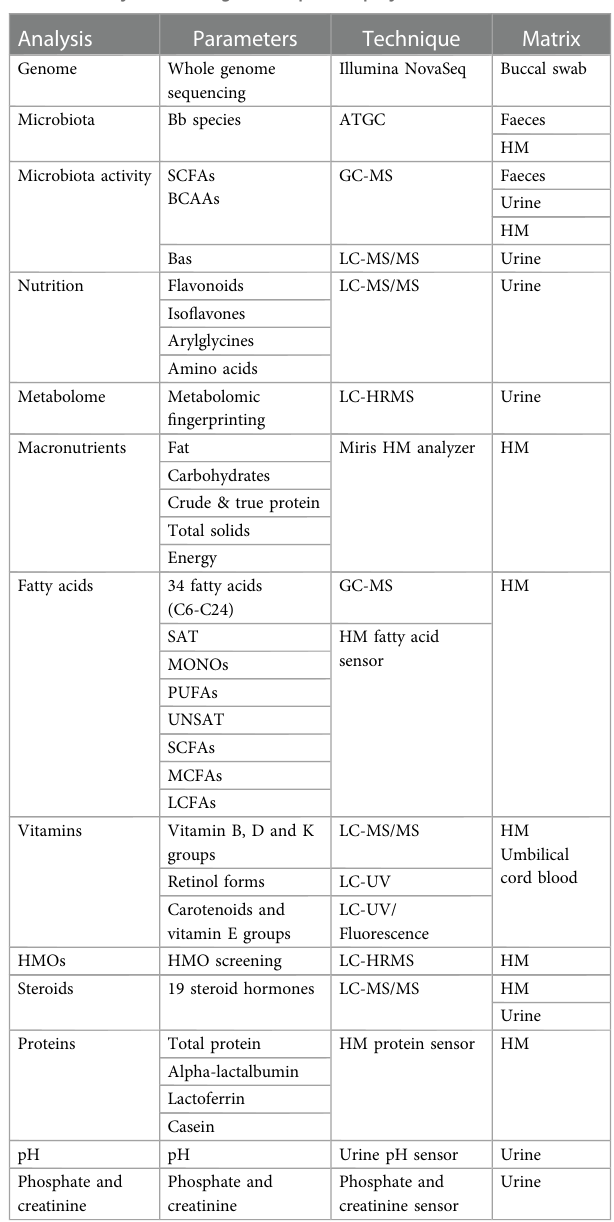
TABLE 2 Analysis of biological samples